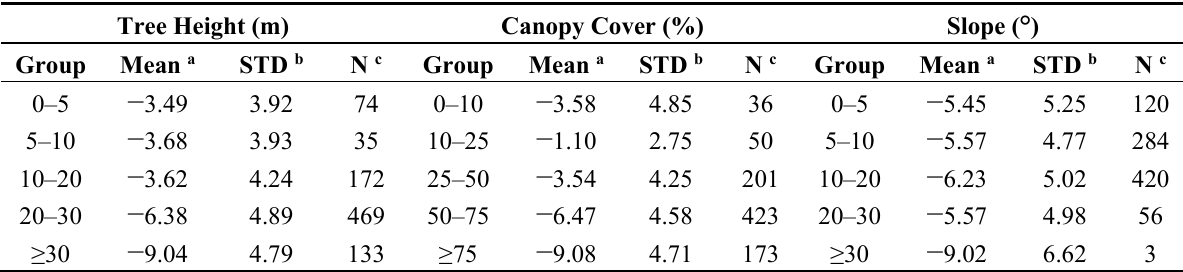
Figure10. ( a ) Histogram of differences between GLAS elevations and the LiDAR DEM (LiDAR DEM minus GLAS elevations); ( b ) Histograms of differences between GLAS elevations and the SRTM DEM (SRTM DEM minus GLAS elevations). µ and σ represent the mean and standard deviation of differences between GLAS elevations and the LiDAR DEM (or the SRTM DEM). Table 3. Statistics for differences between GLAS elevations and the LiDAR DEM (GLAS elevations minus LiDAR DEM), classified by tree height, canopy cover, and slope. Tree Height